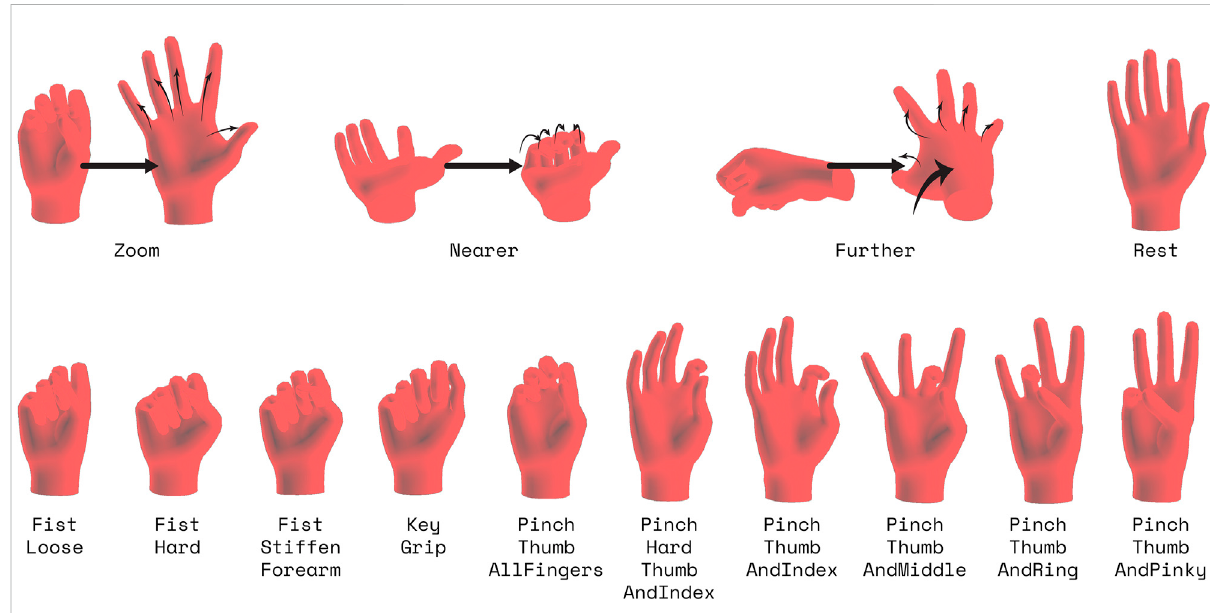
FIGURE 4 Visualizations of the gestures for the Interaction Gestures Task. Note that for the visualization, poses may not be in the orientation as they were when actually performed. For these poses, the user would start in a neutral pose with similar wrist orientations, then perform the